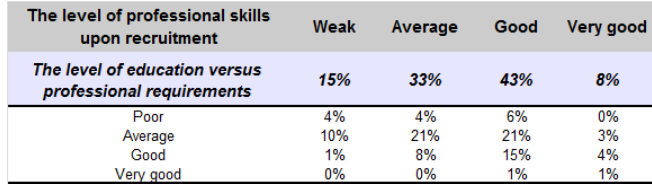
Table 21 - Professional skills and the studies of